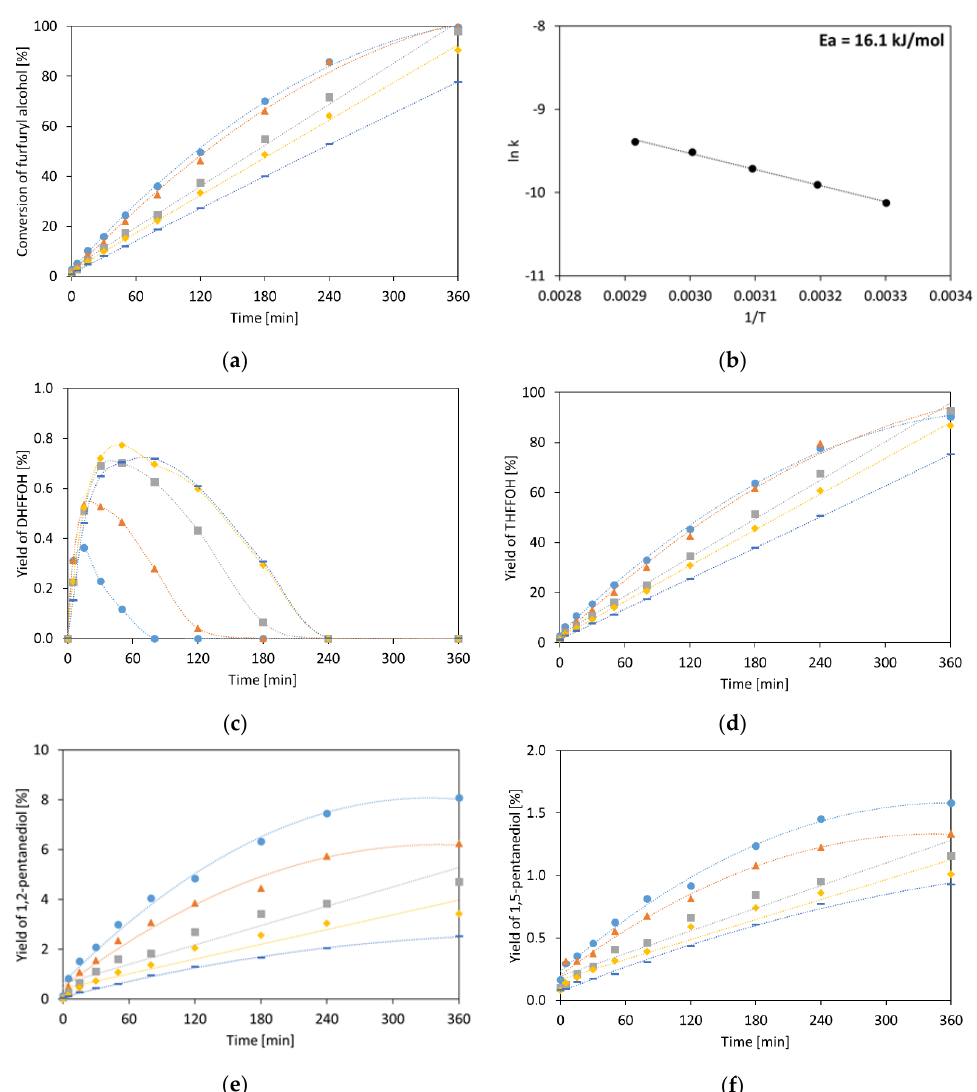
Figure 3. ( a ) Conversion of FFOH, ( b ) Arrhenius plot, Yield of ( c ) dihydrofurfuryl alcohol (DHFFOH), ( d ) tetrahydrofurfuryl alcohol (THFFOH), ( e ) 1,2-pentanediol, and ( f ) 1,5-pentanediol at 30, 40, 50, 60, and 70 °C.